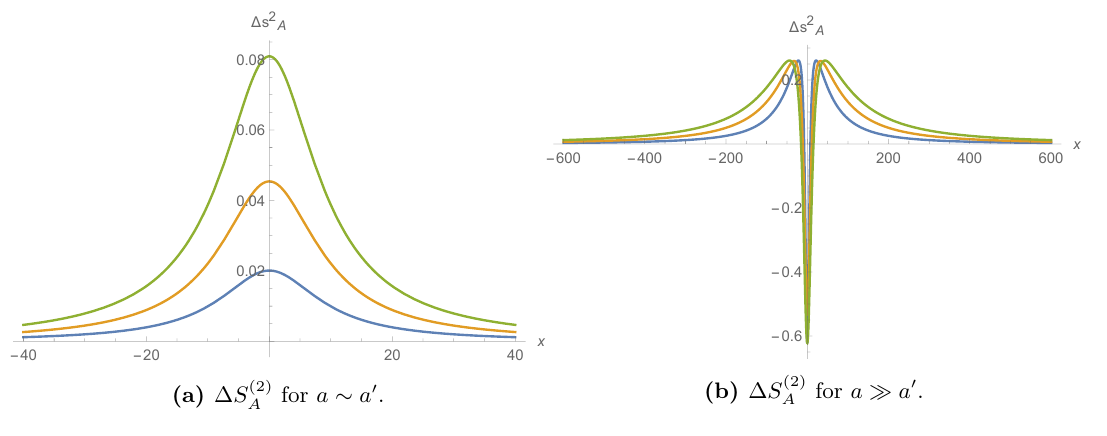
Figure 2. ∆ S (2) as a function of the center of the A